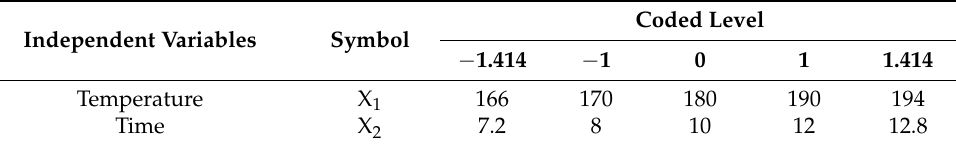
Table 2. Independent variables and their levels in the two factors and three points of central composite design for optimizing the heating conditions of braised mackerel with radish. Independent